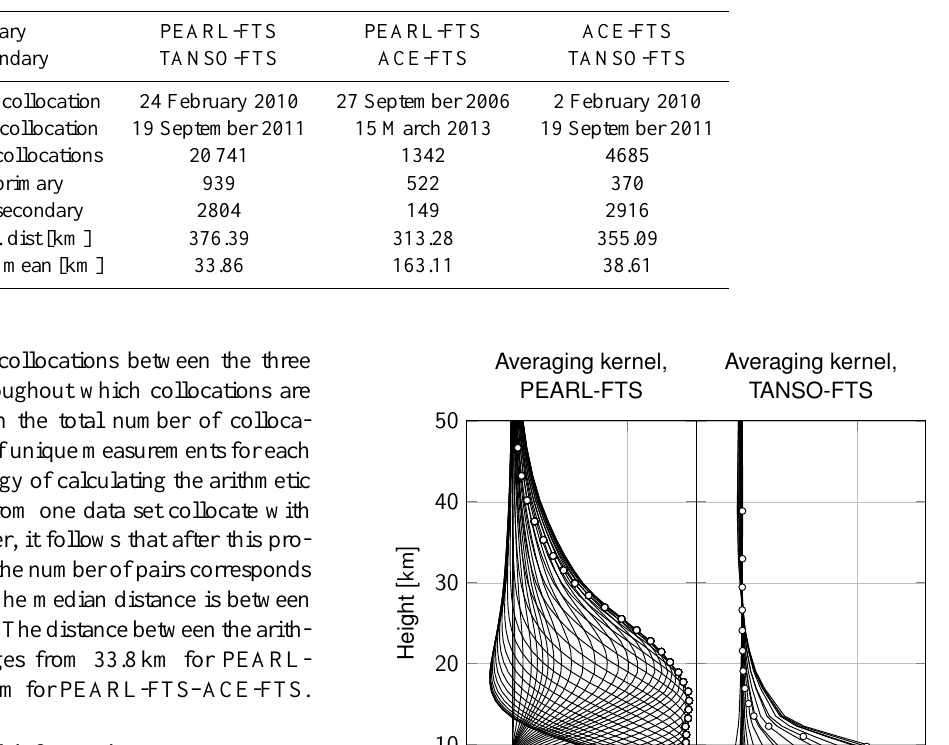
Table 1. Collocation statistics for the different collocation pairs. Collocations between ACE-FTS and TANSO-FTS are limited to the quadran- gle 60–90 ◦ N, 120–40 ◦ W. The total number of collocations considers all pairs before averaging. After averaging, the number of collocations is equal to the number indicated in the row “No. primary”. “Med. dist” is the median distance for all pairs. “Dist. mean” is the distance between the arithmetic mean positions (as calculated using the World Geodetic System (WGS)-84 ellipsoid) of each instrument in the pair.